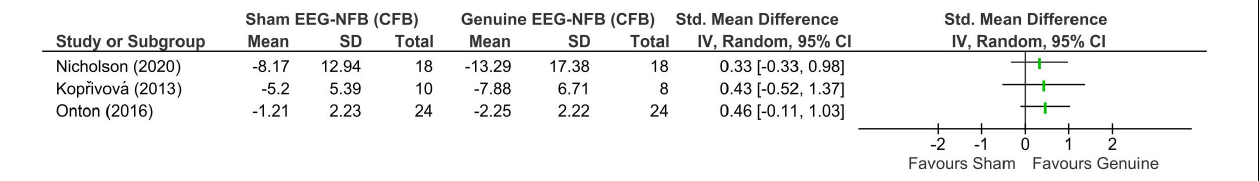
FIGURE 3 | Forest plot showing standardized mean differences in change-from-baseline scores between sham and genuine EEG-neurofeedback using a Hedges’ (adjusted) g. TABLE 3 | GRADE certainty of evidence table. No. of participants